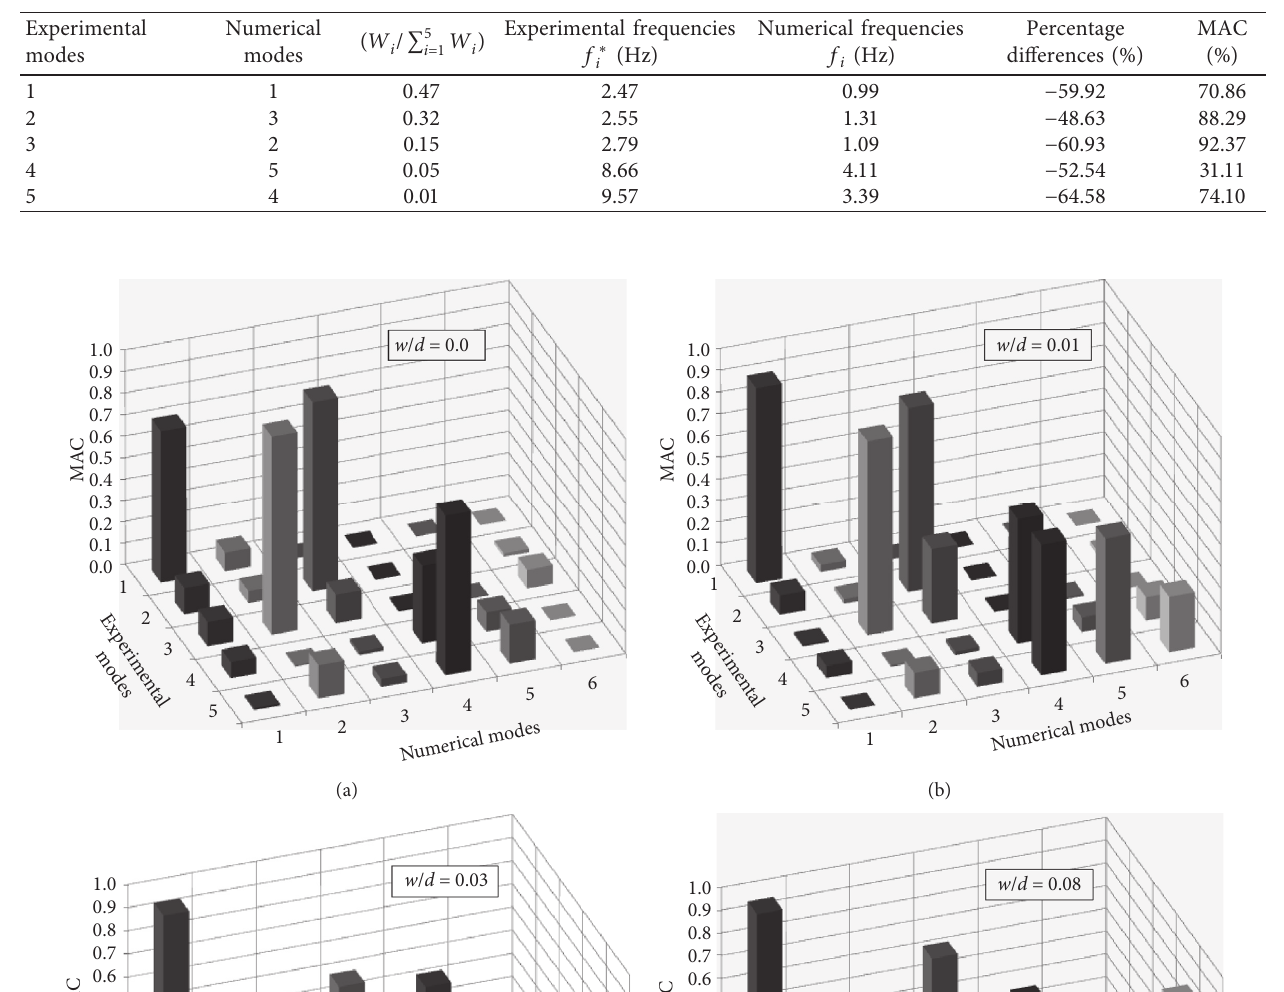
Table 6: Results of modal decomposition analysis obtained not modelling the infill panels (bare structure only) and comparison with experimental